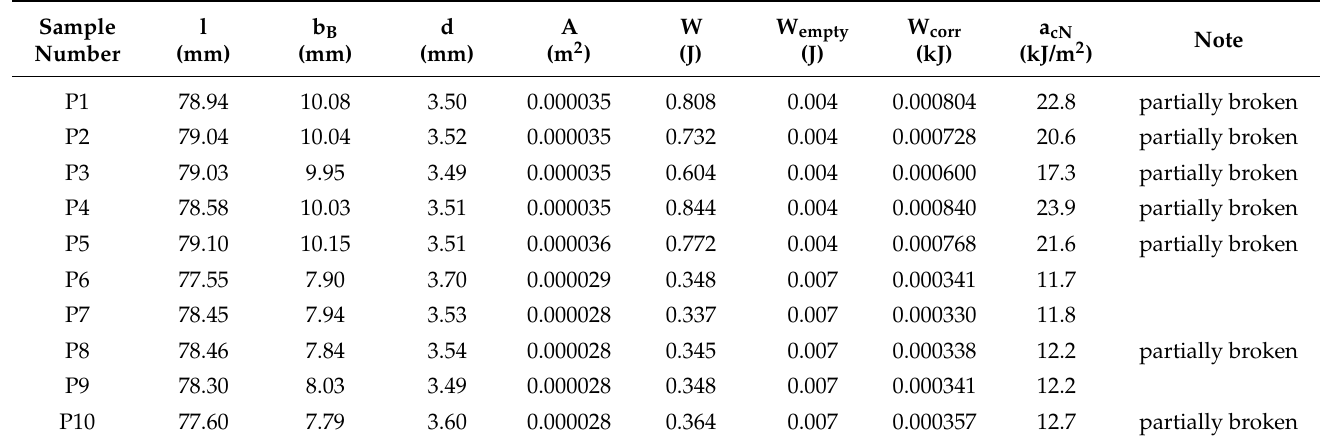
Table A7. Results of the notched impact tests and unnotched impact tests of P_W,PE.